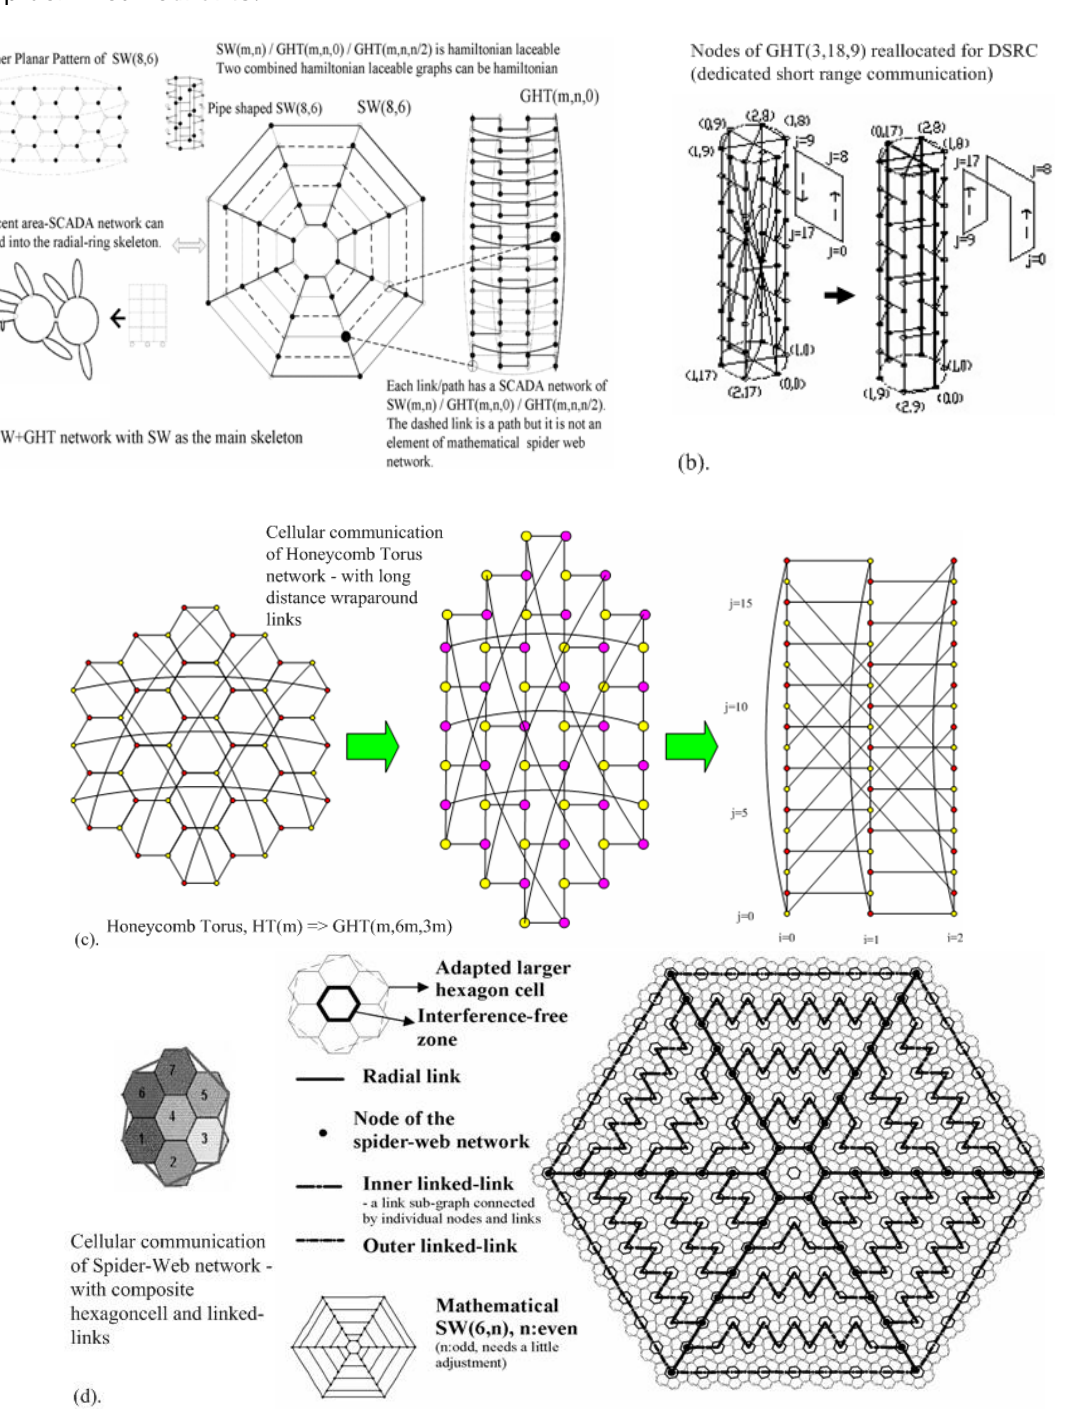
Figure 1. Link adaptability in wide area communication network, ( a ) urban dedicated short range communication network with Spider-Web networks’ integration and fractal connectivity performances; ( b ) wireless communication quality affected by link adaptability; ( c ) cellular communication modeled by honeycomb tori, generalized honeycomb Spider-Web